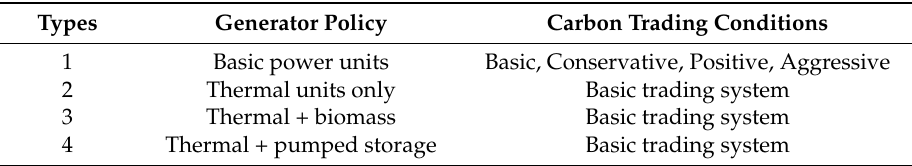
Table 4. Factors analyzed in scenario